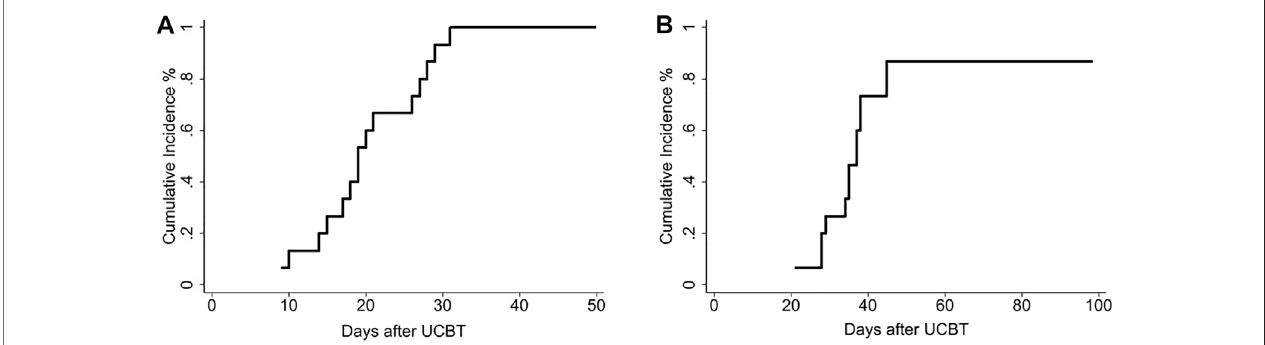
TABLE 2 | Engraftment in recipients of ex-vivo expanded cells. Neutrophil Engraftment n = 15 Time to Engraftment, d, Median (range)